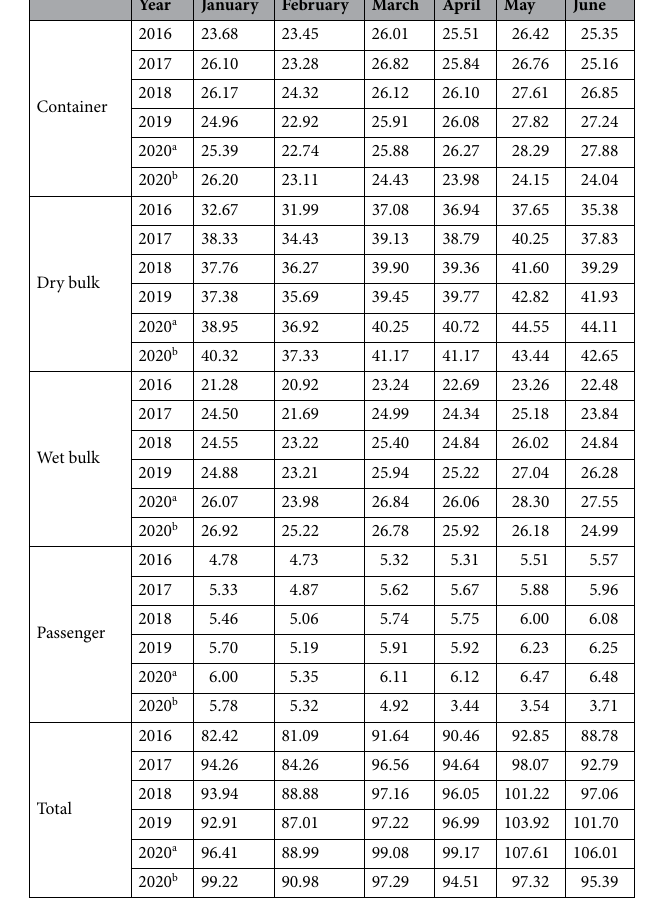
Table 1. Monthly cumulative navigated miles (CNM) [nmi × 10 6 ]. a Forecast mobility levels considering the average growth in past years 2016–2019. b Actual mobility levels recorded in